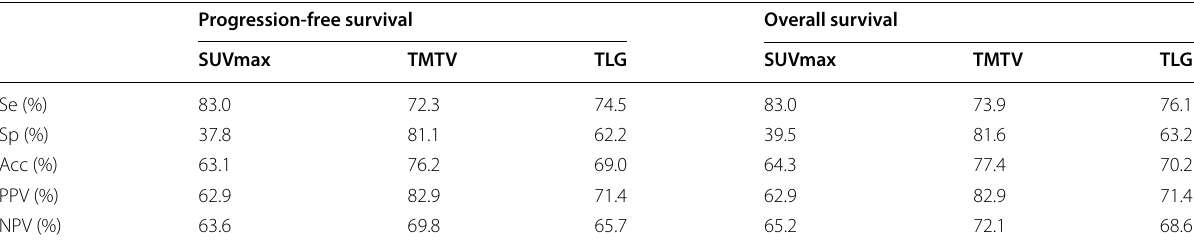
Table 3 Prediction of outcomes with SUVmax, TMTV and